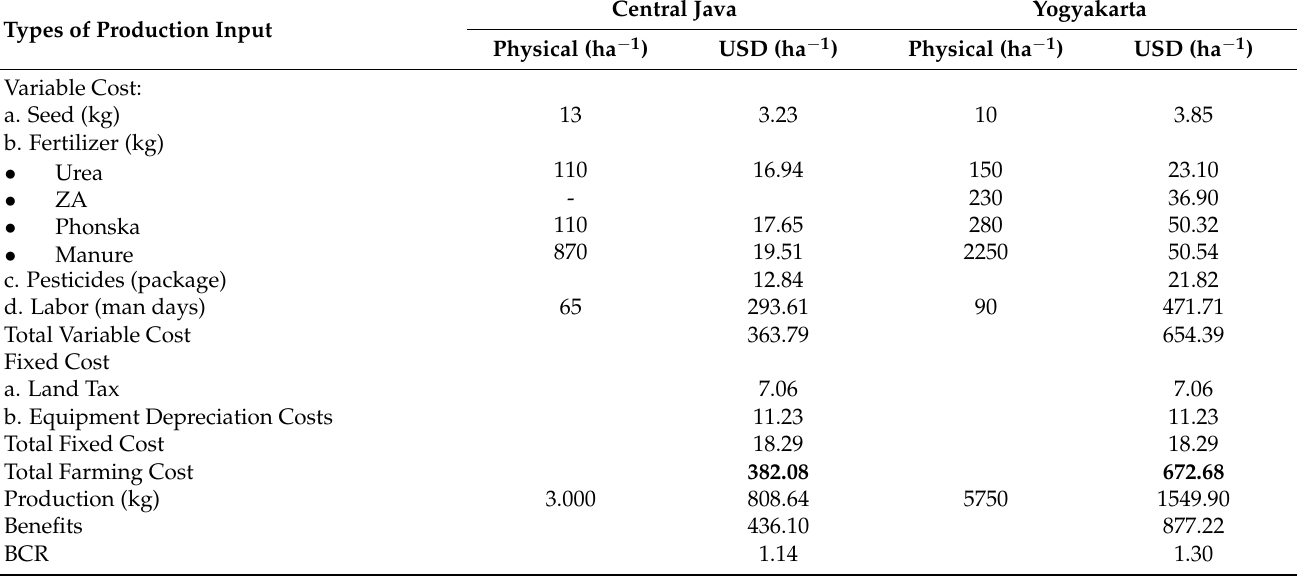
Table 2. Economic value of sorghum farming in Wonogiri Central Java and Gunungkidul Yogyakarta,